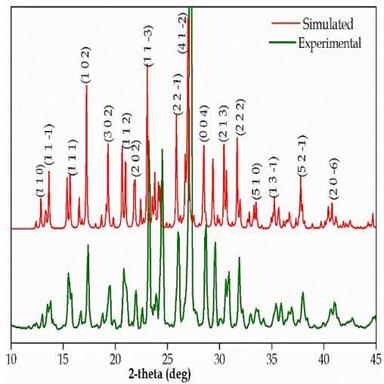
imulated and experimental powder XRD patterns